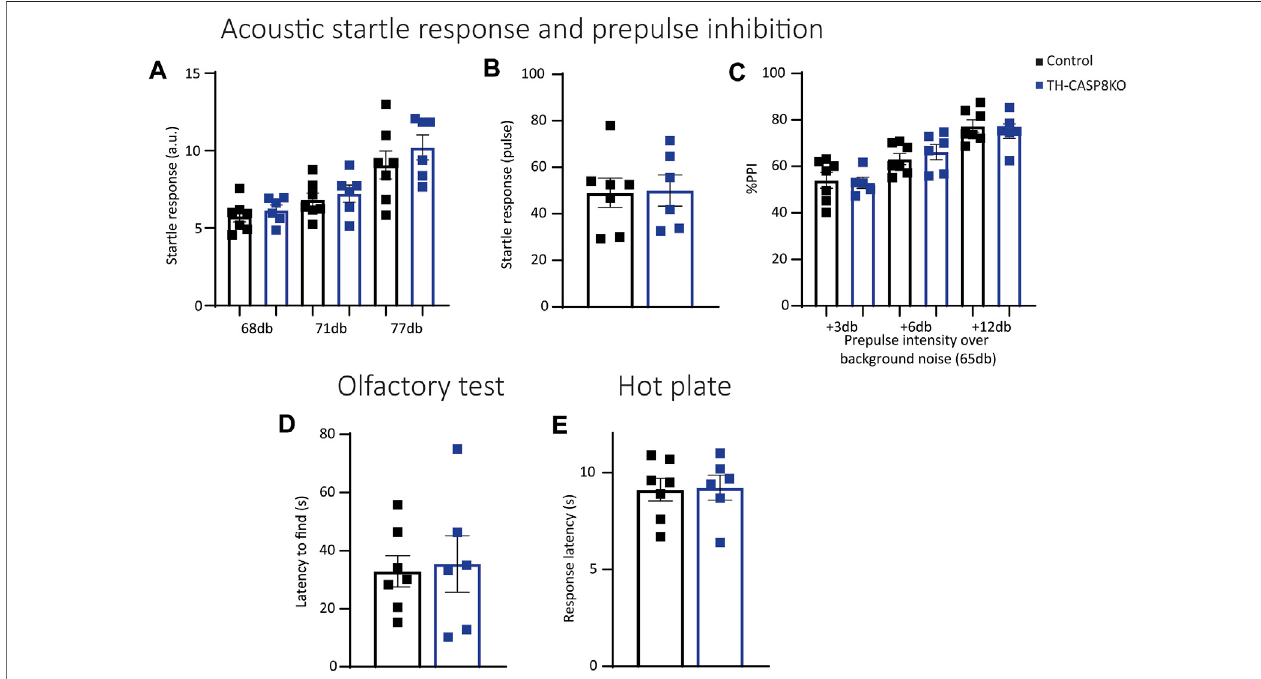
FIGURE 7 | TH-CASP8KO mice exhibit normal responses to sensory stimuli. (A) No signi fi cant differences were detected at all decibel levels in acoustic startle responses to low-intensity pulses in TH-CASP8KO mice. They showed no differences in the auditory startle response to a 120 dB broadband noise pulse (B) or in prepulse inhibition (PPI; when prepulses were delivered at intensities of 3, 6 and 12 dB above a background noise of 65 dB) compared to control mice (C) . (D) TH- CASP8KO mice displayed a similar latency to uncover buried food in olfactory tests with respect to control mice. (E) The response on hot plate in TH-CASP8KO mice and controls measured as mean latency time to jump, lick, or vocalize was similar. Data are expressed as mean ± SEM of n = 6 – 7 mice/group. The two-tailed unpaired t test was used.